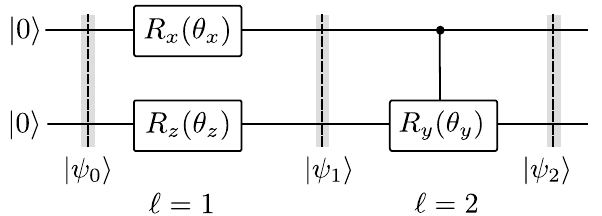
Figure 5. An example quantum circuit for evaluating the Fubini-Study tensor metric. The circuit starts with the ψ 0 00 initial state and evolves under a set of gates R x (θ x ) , R z (θ z ) in layer 1, and CR y (θ y ) in layer 2. Detailed | � = | � of the Fubini-Study tensor metric evaluation for this circuit is provided in the